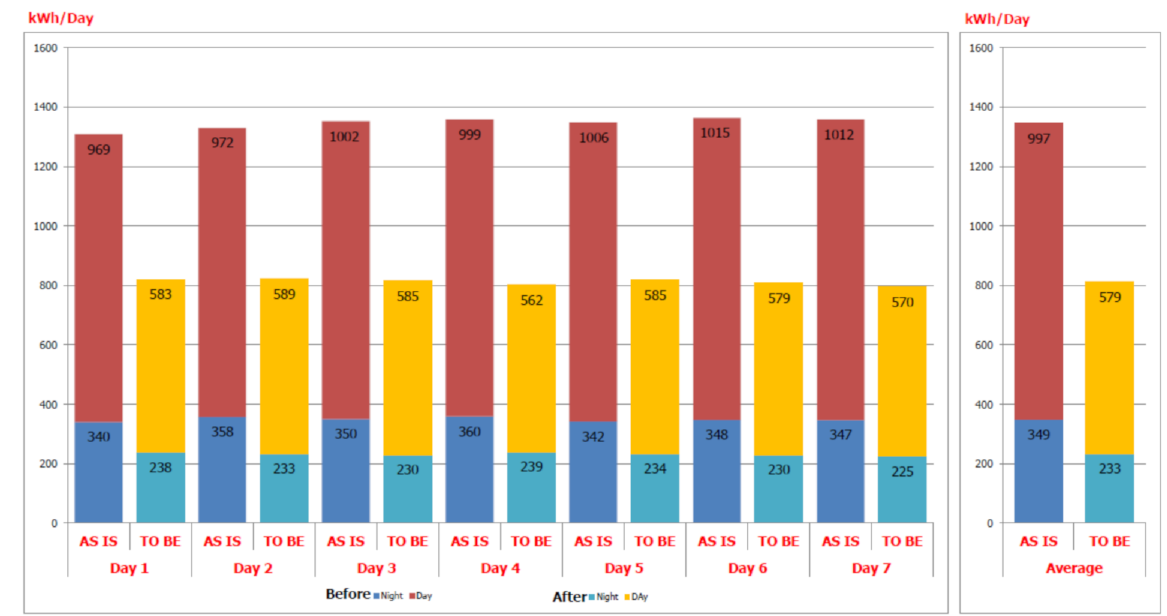
Figure 6. Average power consumption per day before and after door retrofits for store No.1 (R22).